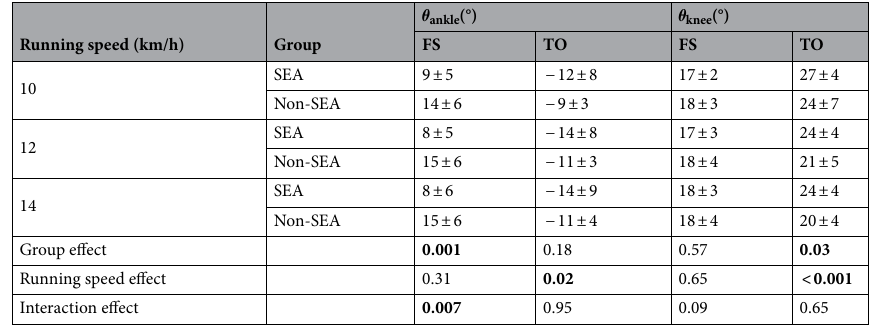
Table 3. Flexion–extension angle of the lower limb for South East Asian (SEA) and non-South East Asian (non-SEA) runners at endurance running speeds. Significant differences ( p ≤ 0.05) identified by linear mixed effects modelling are indicated in bold. θ ankle : ankle joint angle, θ knee : knee joint angle, FS: footstrike, and TO: toe-off.